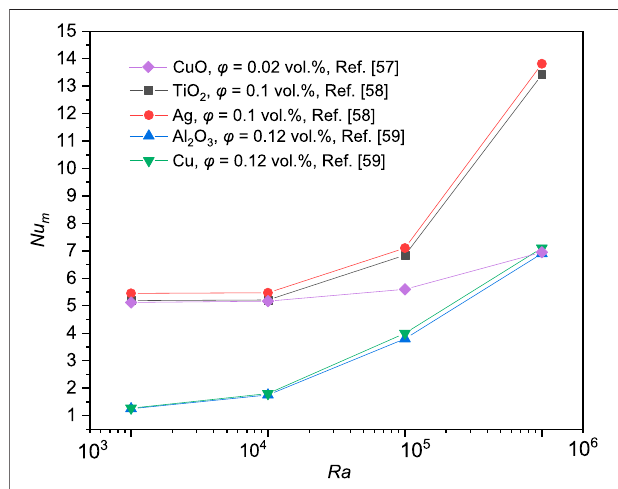
FIGURE 5 | Variations of average Nusselt numbers of water-based nano fl uids with various Rayleigh numbers in a square cavity.